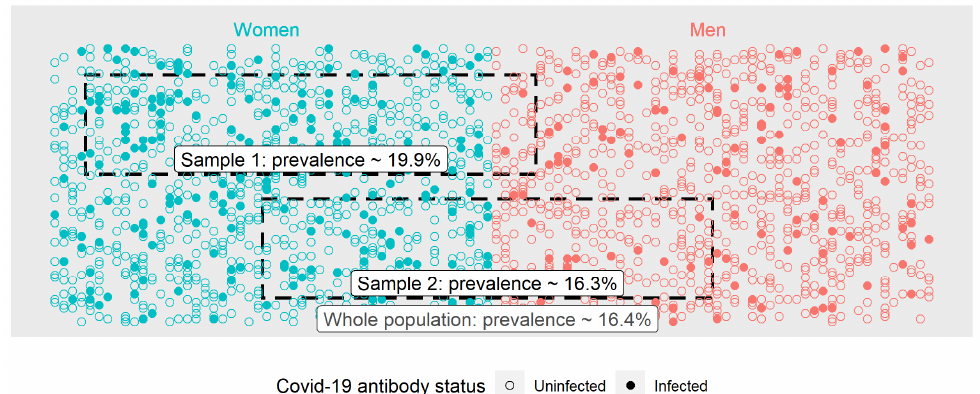
Figure 2. Importance of representative sampling. In this population, the rate of prior infection is higher among women. As a result, Sample 1, which is predominantly women, overestimates the prevalence of prior infection among the wider population. By contrast the prevalence in Sample 2, which contains approximately equal numbers of men and women, is much closer to that of the wider population.